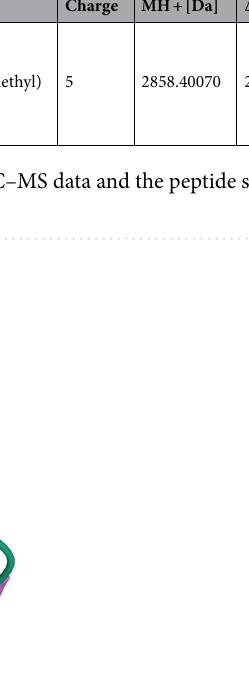
Figure 3. A 3-D model of peoriaerin IBSD35 predicted using de novo modeling. The amino acids composition of peptide is AAGIQAQAGFGLSDSIQGTGKQKCSFCK. Sequence contains high Gly content. It is indicated in black color. Glycine is integral to the formation of alpha-helices in secondary protein structure due to its compact form. The purple color indicated the helix structure property. It included the green color which intersects with the purple color. The green color indicated the residues embedded in membrane. The light orange color indicated the Trp which is the rings in the residues. The red color indicated the Ala. The whole structure represented the backbone and side chain of the AMP except the Gly indicated in black